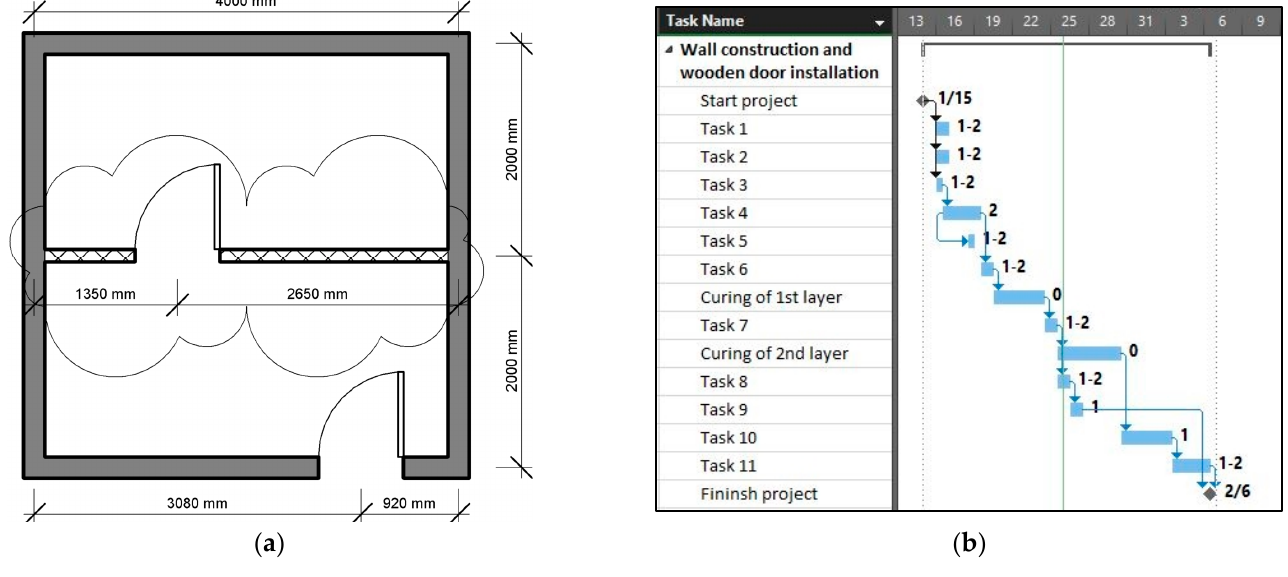
Figure 2. ( a ) General view of the floorplan and ( b ) Gantt chart of main activities used as the baseline for the required scope summarized in Table 2.